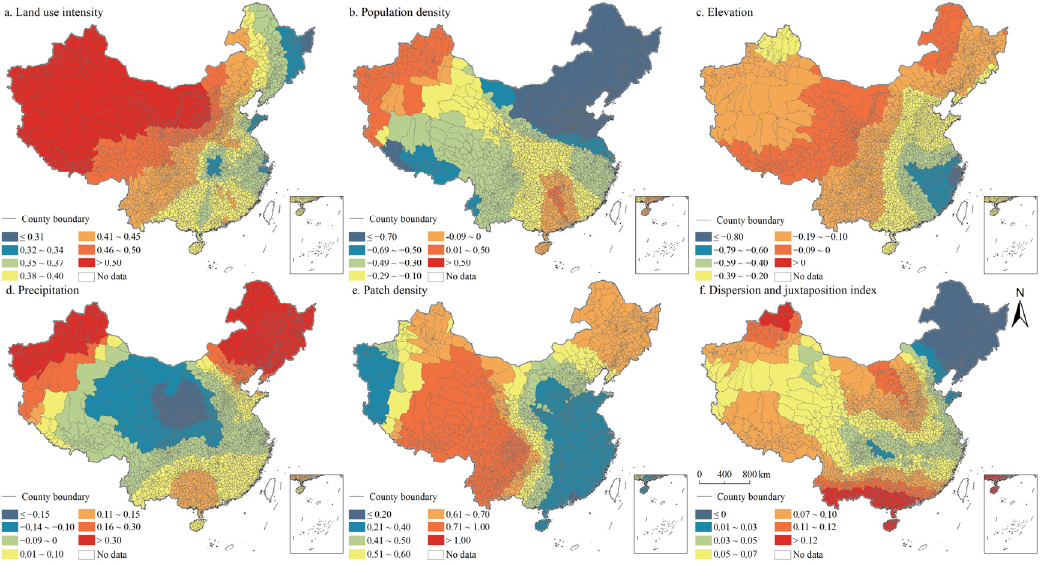
Figure 16. Spatial distributions of the regression coefficients of GWR model in China in 2020.